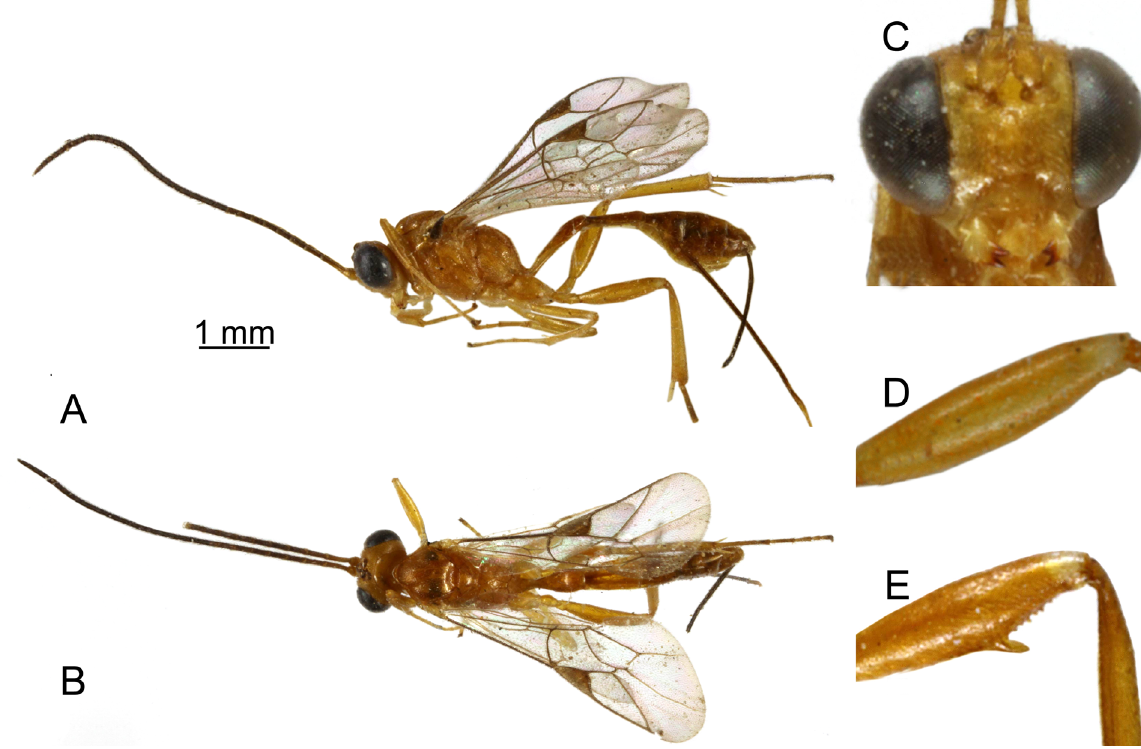
Fig. 8. Pristomerus kelikely sp. nov. A . ♀, habitus, profile. B . ♀, habitus, dorsal. C . ♀, head, facial. D . ♀, hind femur, profile. E . ♂, hind